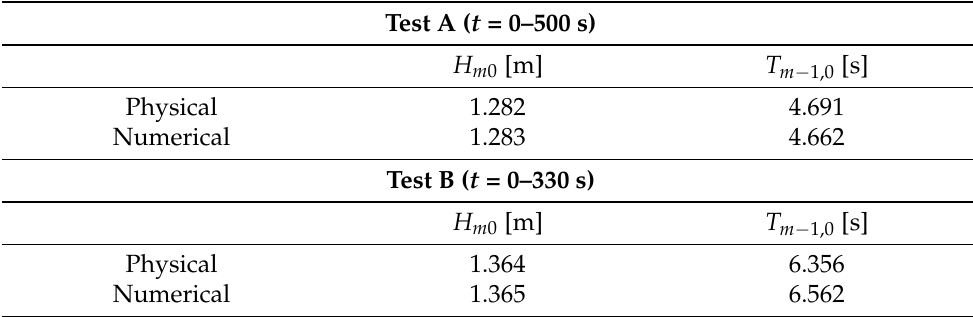
Table 4. Significant wave height and spectral wave period of physical test and numerical